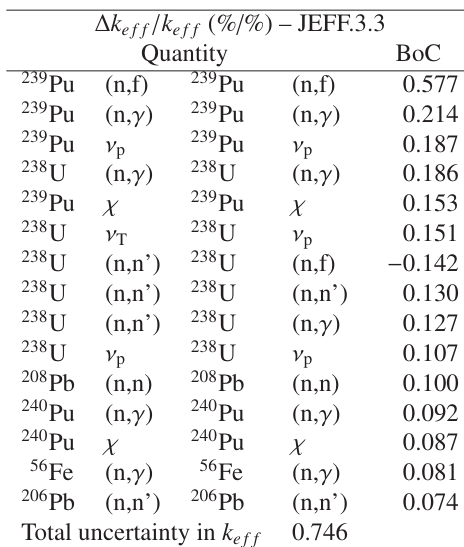
Table 3. k ef f uncertainty quantification for ALFRED at BoC with ENDF /